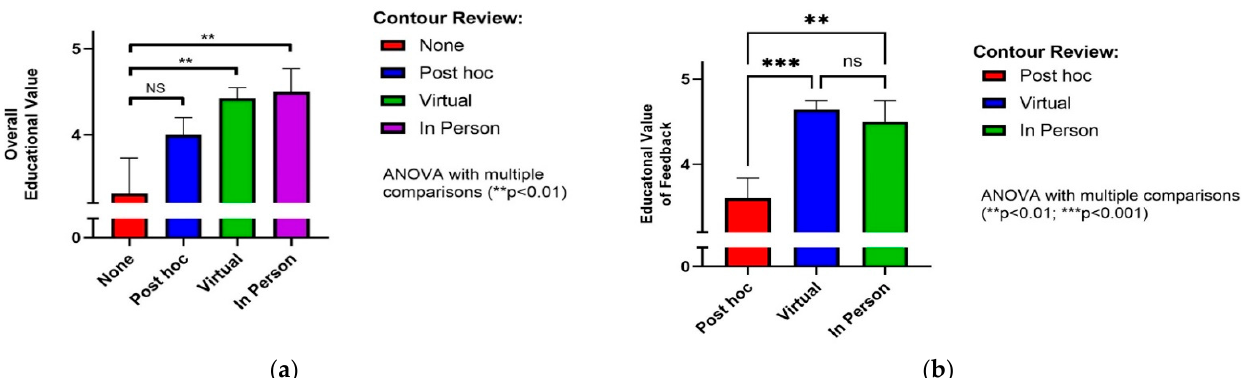
Figure 4. Resident-reported educational values. ( a ) Cases reviewed virtually or in person were statistically ranked higher than those not reviewed. ( b ) Virtual review was ranked significantly more favourable than post hoc review, but similar to in person review. ** p < 0.01, *** p < 0.001. Table 1. Example learning pearls grouped by themes.